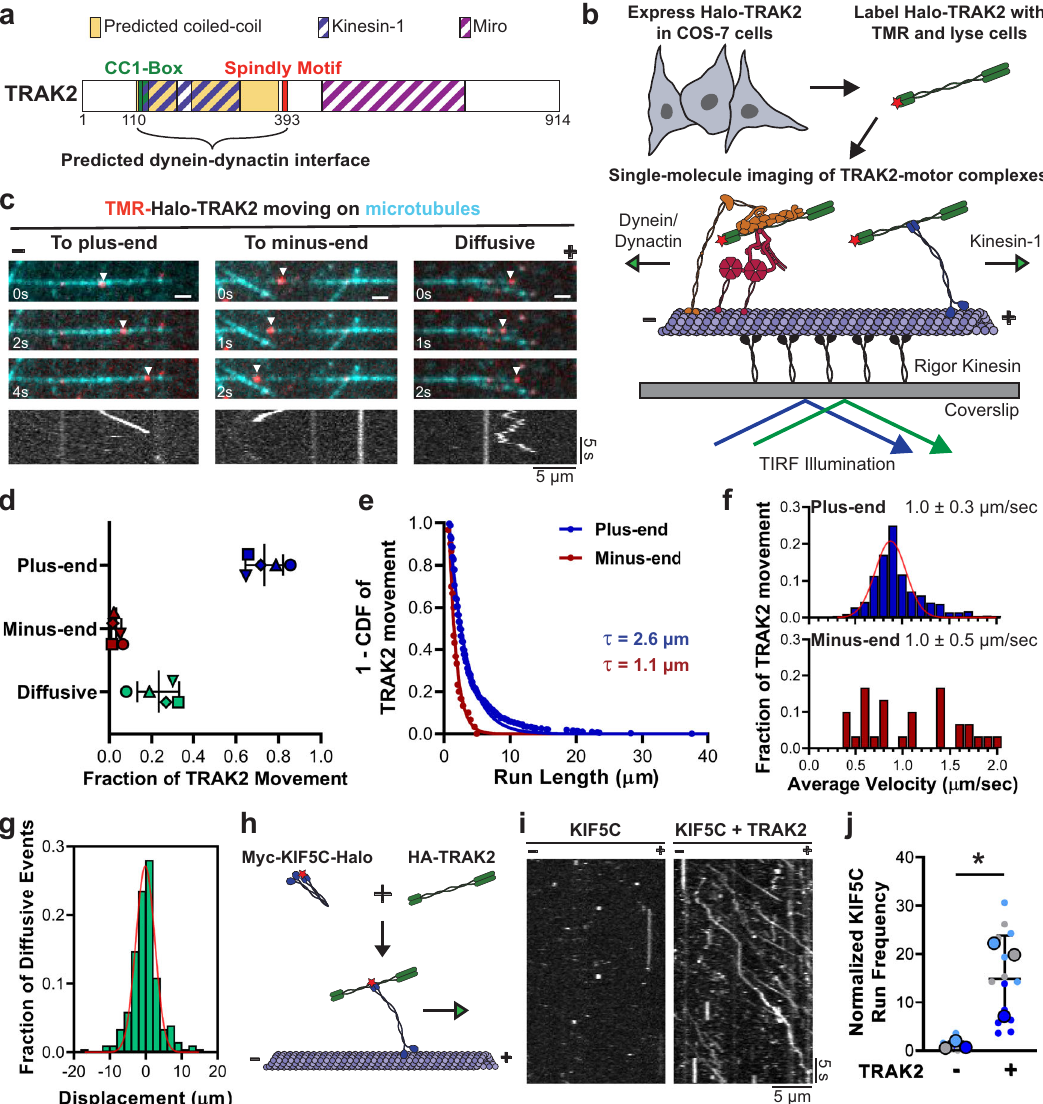
Fig. 1 TRAK2 activates kinesin-1. a Diagram of TRAK2 with binding regions for kinesin-1 and Miro, conserved dynein adaptor motifs, and predicted coiled- coil domains. b Schematic depiction of the experimental design with an illustration of TMR-labeled Halo-TRAK2 in complex with dynein – dynactin or kinesin-1. c Time series and corresponding kymographs showing single Halo-TRAK2 particles (arrow) moving to the plus-end, minus-end, and bidirectionally along dynamic microtubules. White scale bars = 2 µ m. d Fraction of occurrence for each type of TRAK2 movement. Data points are shaped according to experimental replicate. The center line and bars are the mean ± s.d. from fi ve independent experiments. e , f Inverse cumulative distribution functions (CDF) of run length and histogram distributions of velocity for TRAK2 transport to either microtubule end ( n = 758 plus-end events and 30 minus-end events). The curves in ( e ) represent a single exponential decay fi t, with decay constant indicated above. In f , the red curve represents a Gaussian distribution fi t. In f , the mean ± s.d. is shown. g Distribution of run displacement of TRAK2 diffusive movement ( n = 203 events). Negative displacement indicates movement to the microtubule minus-end. The red line represents a Gaussian distribution fi t. h Schematic of KIF5C activation experiment. i Representative kymographs showing activation of KIF5C upon co-expression of TRAK2. j Normalized frequency of KIF5C motility with and without exogenous TRAK2. Data points are color-coded according to experimental replicate, with smaller points representing KIF5C frequency per video. The center line and bars are the mean ± s.d. from three independent experiments ( n = 14 videos without TRAK2 and 11 videos with TRAK2) * p = 0.0320 (two-tailed t